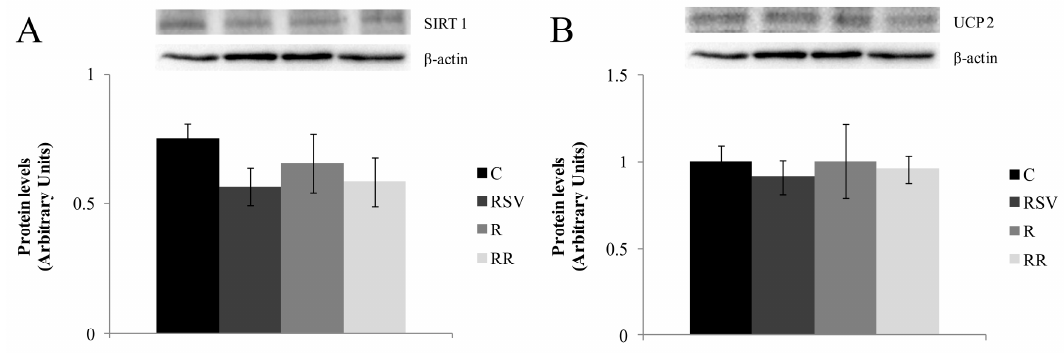
Figure 7. SIRT1 ( A ) and UCP2 ( B ) protein expression in liver from rats fed an obesogenic diet for six weeks and then fed a standard diet (C), or a standard diet supplemented with resveratrol (RSV), or submitted to energy restriction and fed a standard diet (R) or submitted to energy restriction and fed a standard diet supplemented with resveratrol (RR) ( n = 9/group) for additional six weeks. Values are mean ± SEM. Differences among groups were determined by using one-way ANOVA followed by Newman Keuls post-hoc test. Values not sharing a common letter are significantly different ( p < 0.05). SIRT1: sirtuin 1, UCP2: uncoupling protein